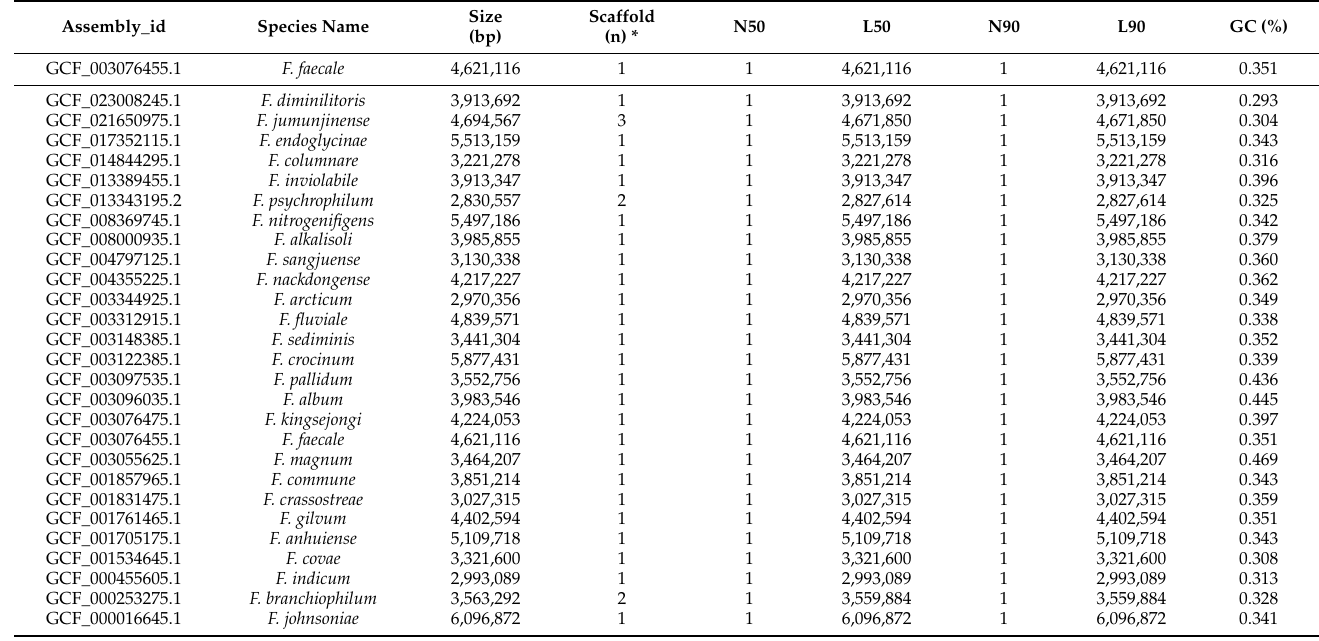
Table 4. Information of 27 representative genomes of Flavobacteria strains.